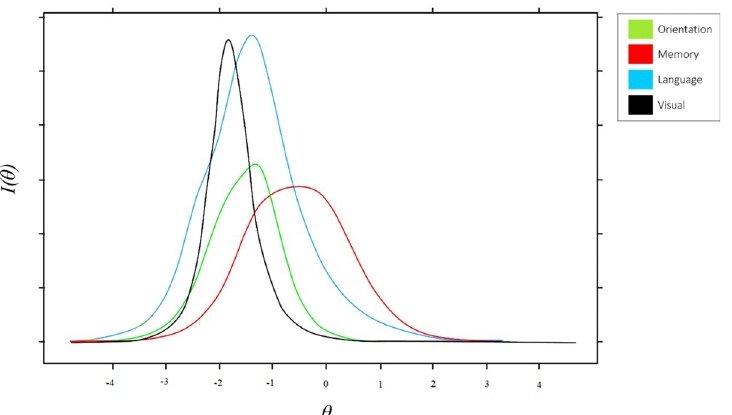
Fig 1. Information functions curves of subscale of